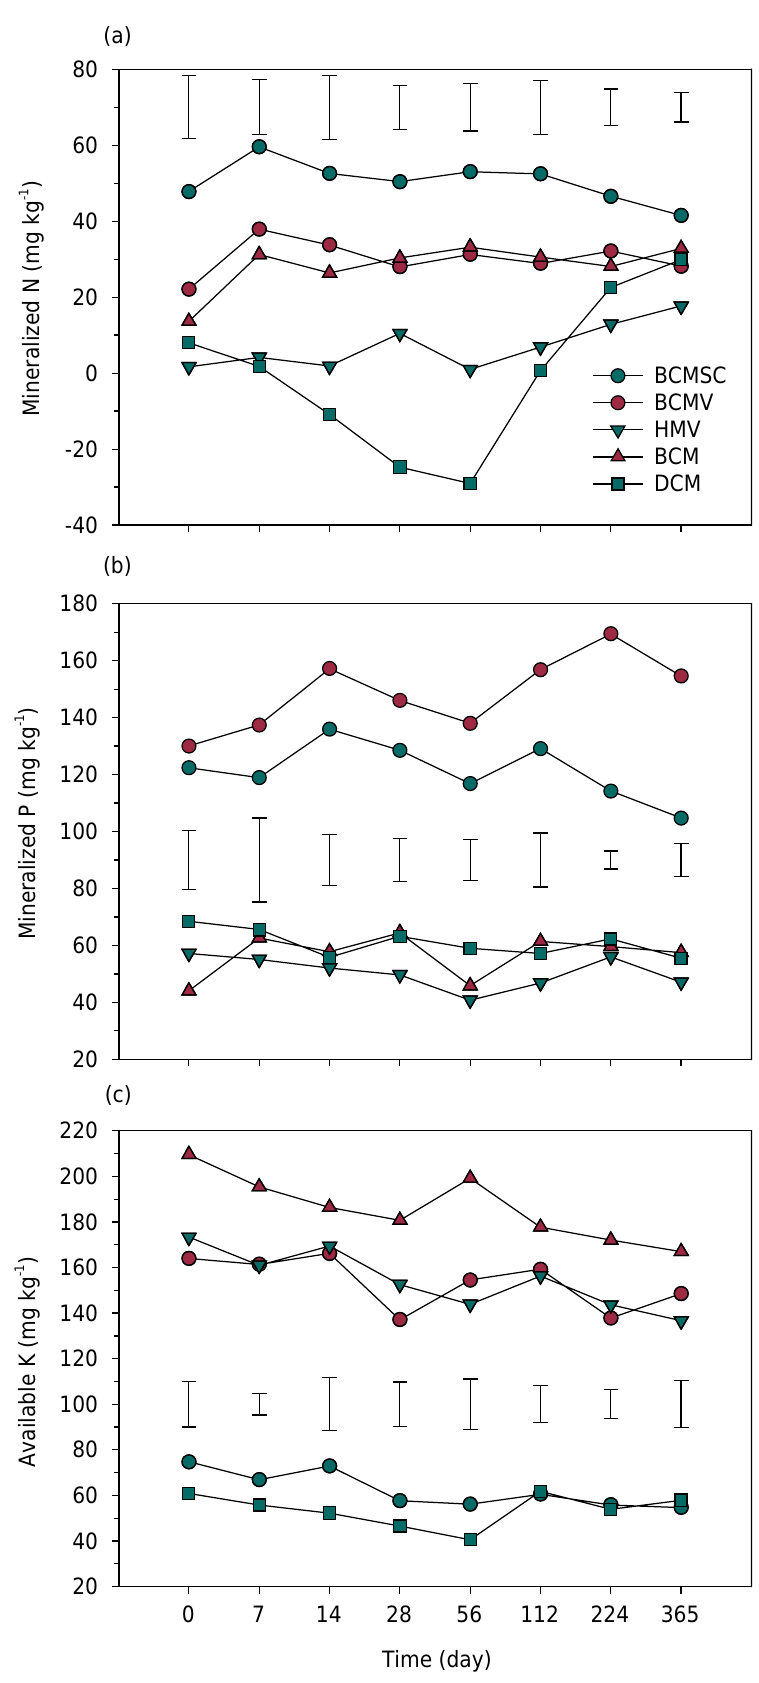
Figure 1. Nitrogen (a) and phosphorus (b) net mineralization, and available potassium (c) of the organic fertilizers in the soil. Beef cattle manure/straw compost (BCMSC); beef cattle manure vermicompost (BCMV); high moisture vermicompost (HMV); beef cattle manure (BCM); and dairy cattle manure (DCM). Values indicate the means of the four replicates. Vertical bars represent the least significant difference (Tukey test,